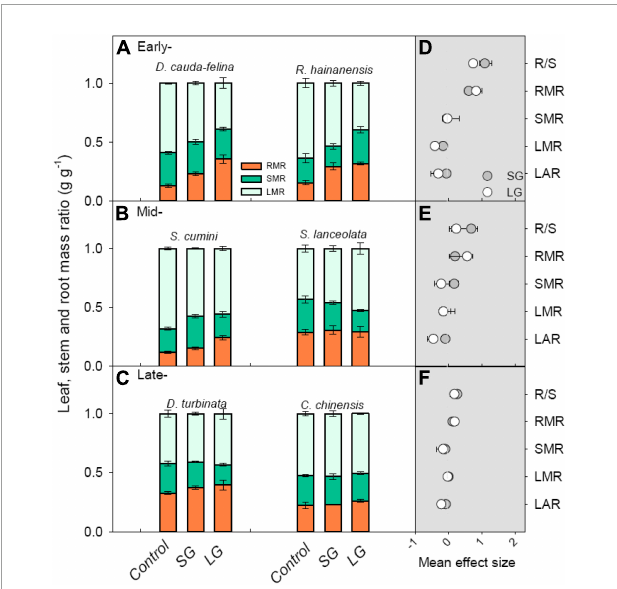
FIGURE3 Leaf, stem and root mass ratio [LMR, SMR, and RMR, (A–C) ] of seedlings in Control, SG, and LG, and the mean effect size (D–F) of SG and LG on root: shoot ratio (R/S), root, stem, and leaf mass ratio (RMR, SMR, and LMR), and leaf area ratio (LAR) for tree seedlings at early- (D) , mid- (E) , late-successional stage (F) . Control, 0–5% of full sunlight; SG: small canopy gaps, 10–15% of full sunlight; LG: large canopy gaps, 40–50% of full sunlight. The bars in plots (A–C) and (D–F) represent standard error ( n = 5 plants) and 95% confidence interval (CI), respectively. If the CI in plots (D–F) did not overlap with zero (the gray dotted line), a significant mean effect of SG and/or LG was considered ( P <